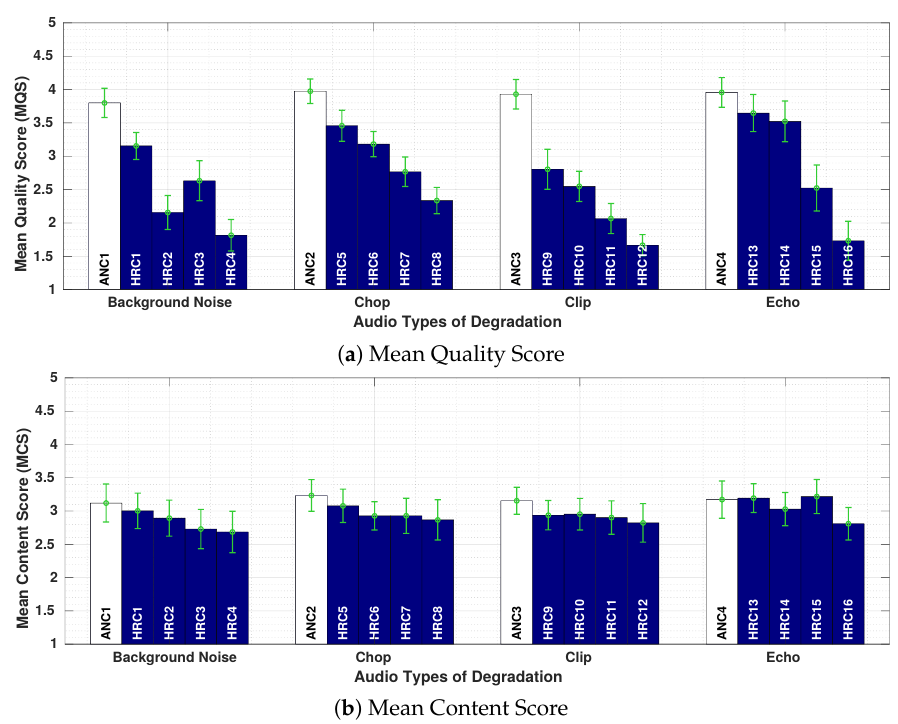
Figure 8. Mean Quality Score (MQS HRC ) and Mean Content Score (MCS HRC ) for the different Hypothetical Reference Circuit (HRC) in Experiment